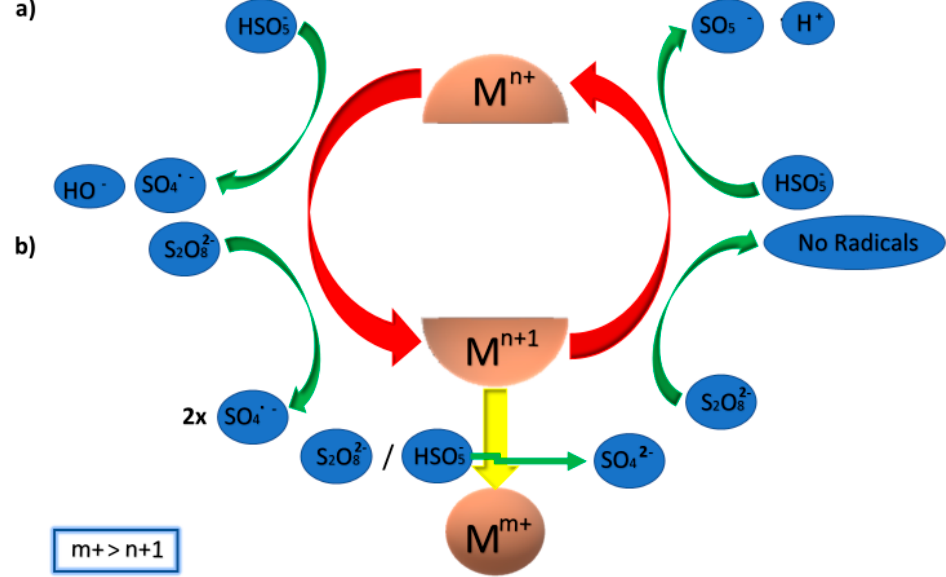
Figure 1. Schematic activation of ( a ) PMS and ( b ) PS by transition metals.